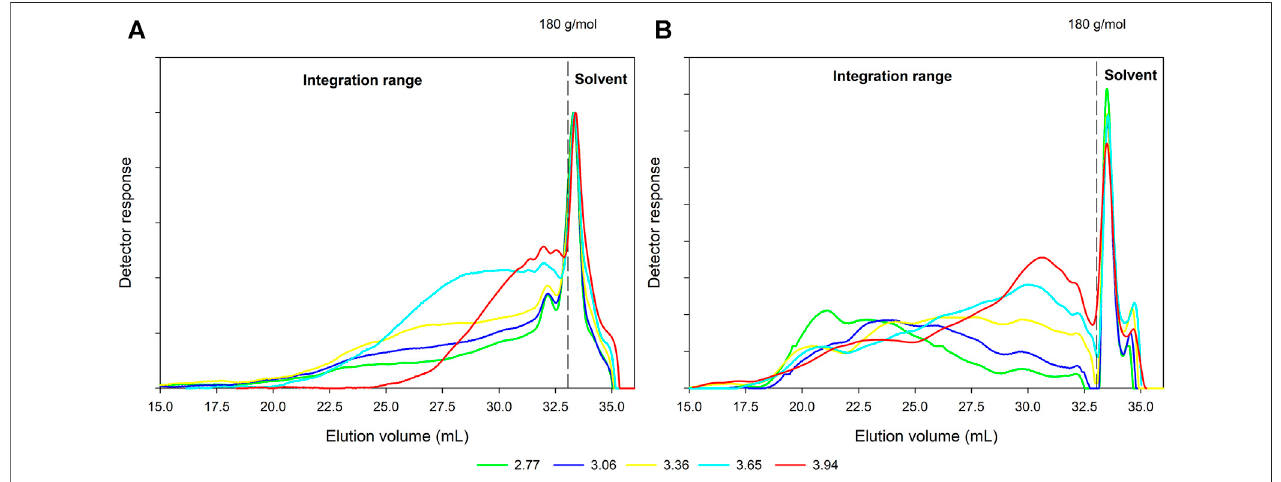
FIGURE 1 | SEC elution pro fi les of fi ltrates obtained from CS (A) and MS (B) .